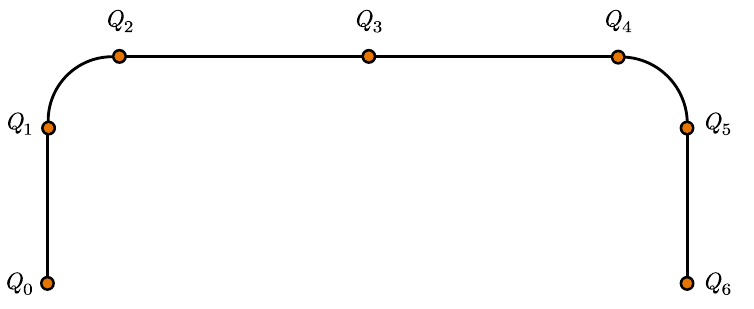
Figure 7. Trajectory discrete point sequence.